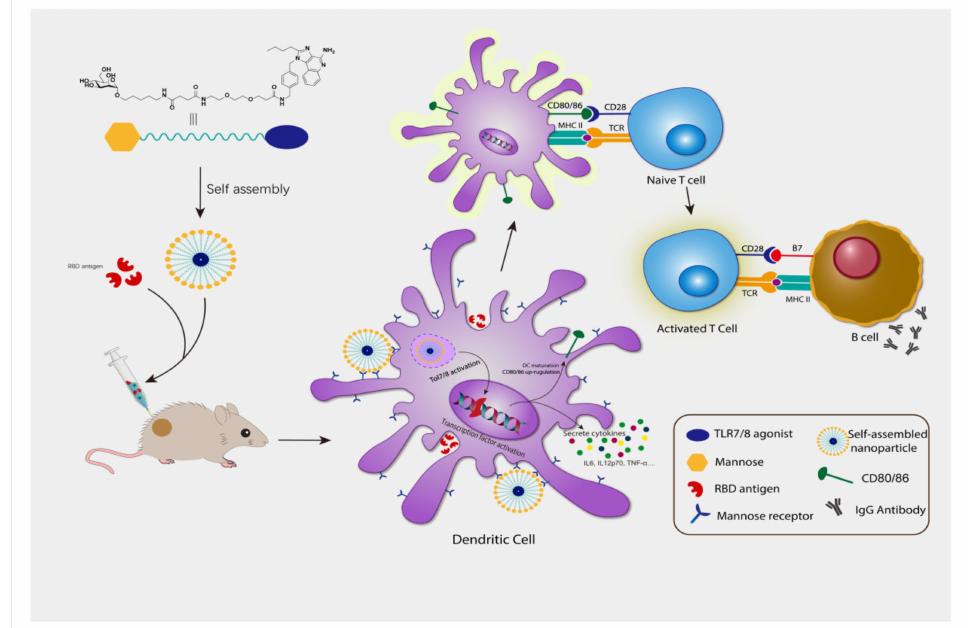
Figure 4. Concept of mannose-TLR7/8 agonist conjugate nanoparticle fabrication and immune cells